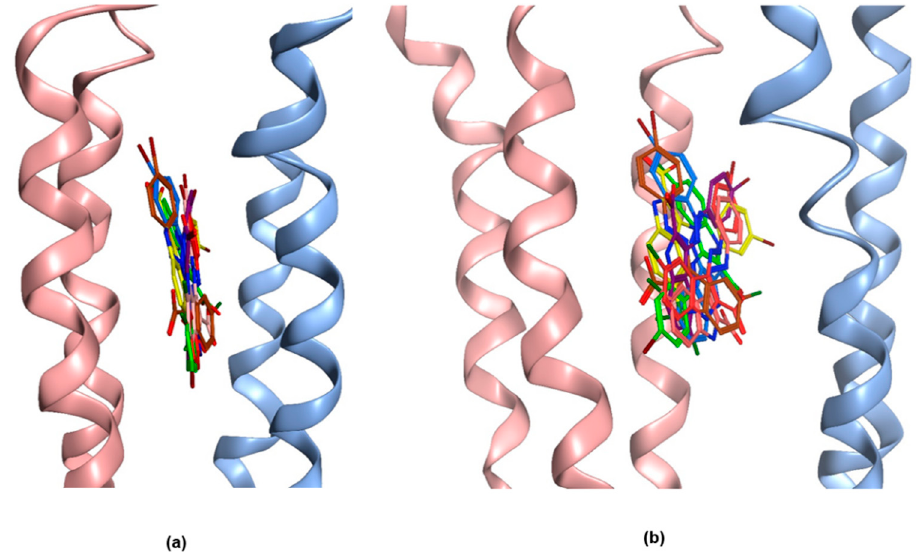
Figure A3. Different binding poses of MTI163 in 6HUP. Top 20 poses from GoldScore and ChemScore ranking were analysed, and the seven poses thatremain among top 20 by consensus (i.e., in ranks 1–20 in both scoring functions) are depicted here. ( a ) Front view; ( b ) Side view.